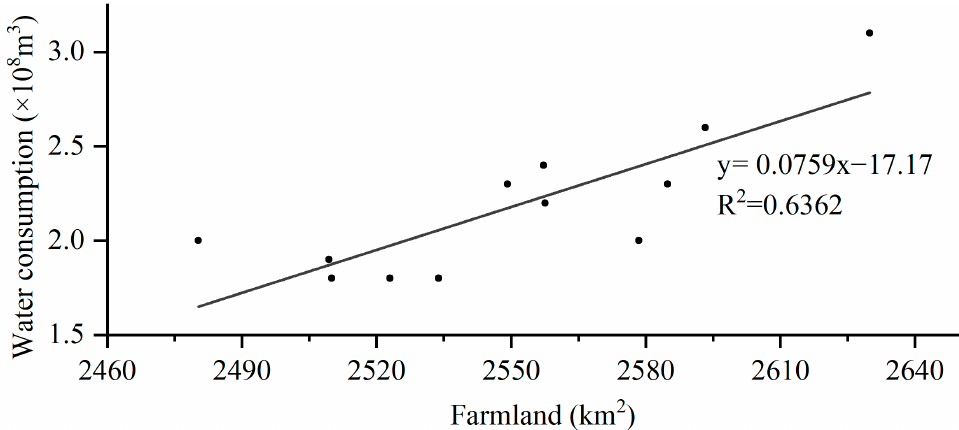
Figure 10. Relationship between farmland area and water consumption in 2007–2018.